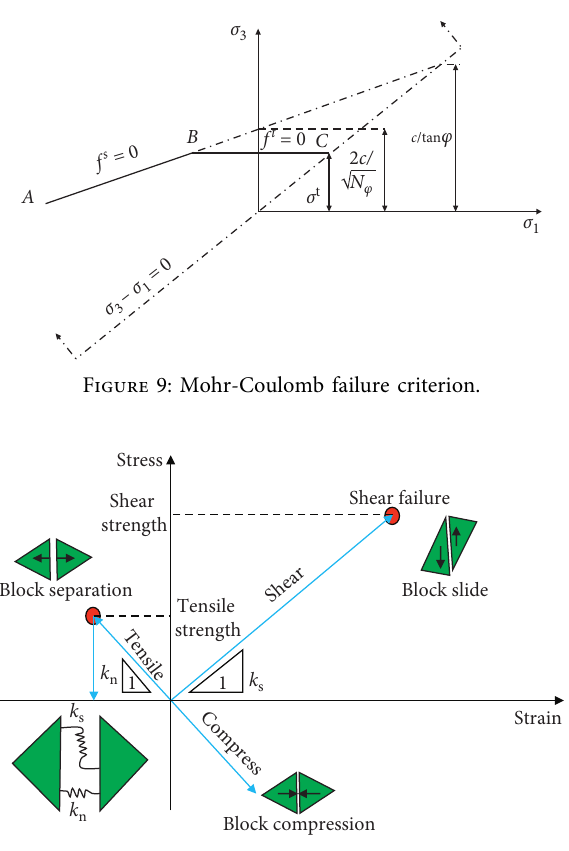
Figure 10: Yielding process of the